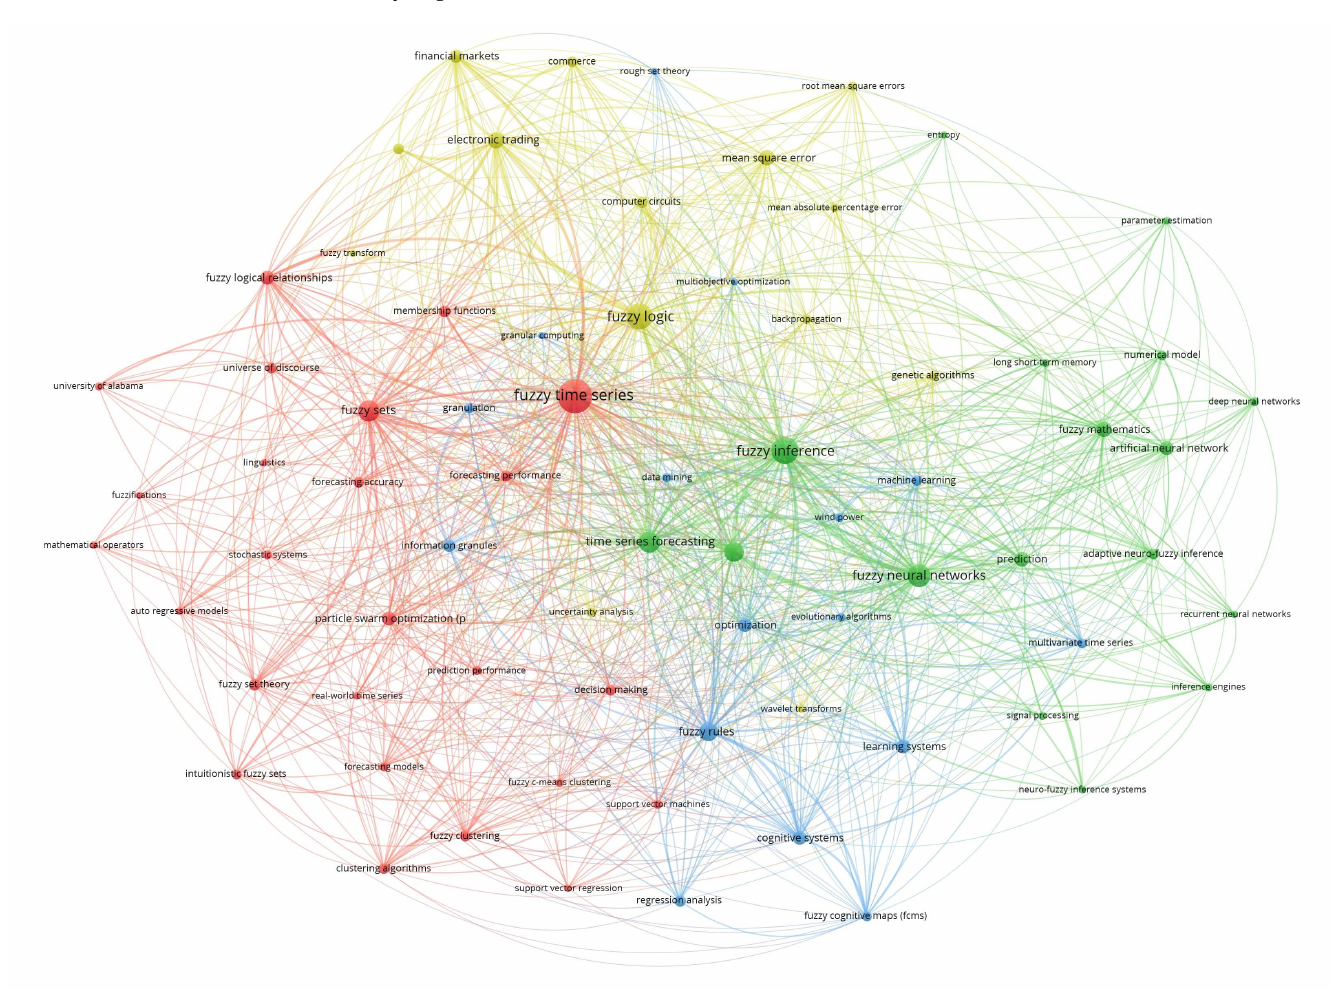
Figure 7. Co-word